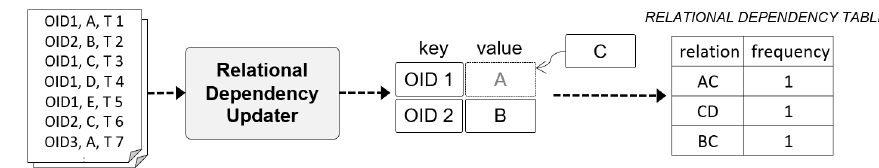
Figure 4. Example of input and output data for Relational Dependency Updater.